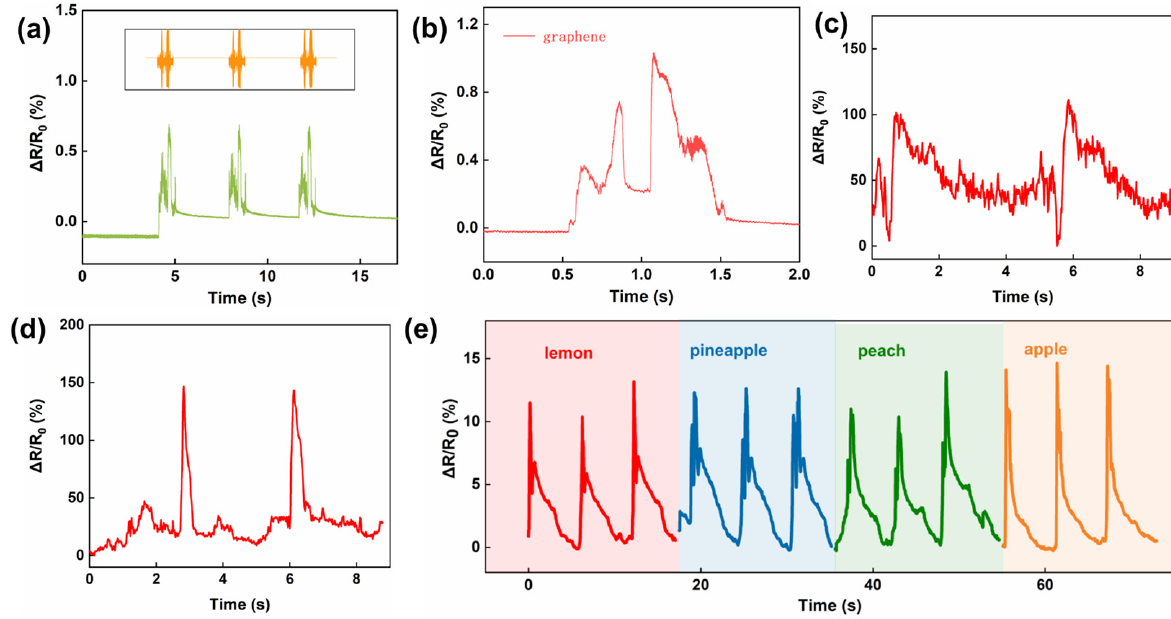
Figure 5. Sound and throat movement detected by SCG e-skin. ( a ) The comparison between the initial audio wave of a chirp and the corresponding sound vibration signal. ( b ) The response to the English word “graphene” from a loudspeaker. ( c ) Throat muscle movement of cough detected by SCG e-skin attached to the throat. ( d ) Throat muscle movement makes an “ah” tone detected by SCG e-skin attached to the throat. ( e ) Responses toward the sound “lemon”, “pineapple”, “peach”, and “apple” when the device is attached to the throat.